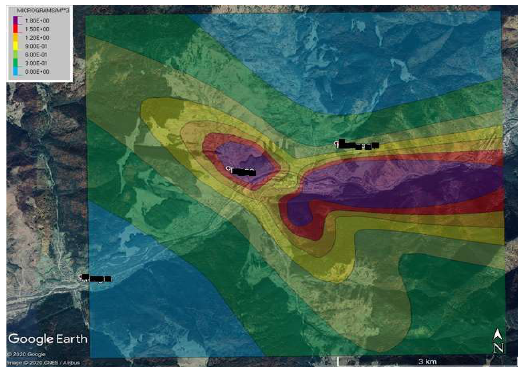
Figure 16. Annual NOx concentration in the area of interest—Google Earth Pro. The modeled NOx concentrations indicate that the maximum hourly and annual values comply with the limit values provided in Law 104/2011, according to the data presented in Table 8.